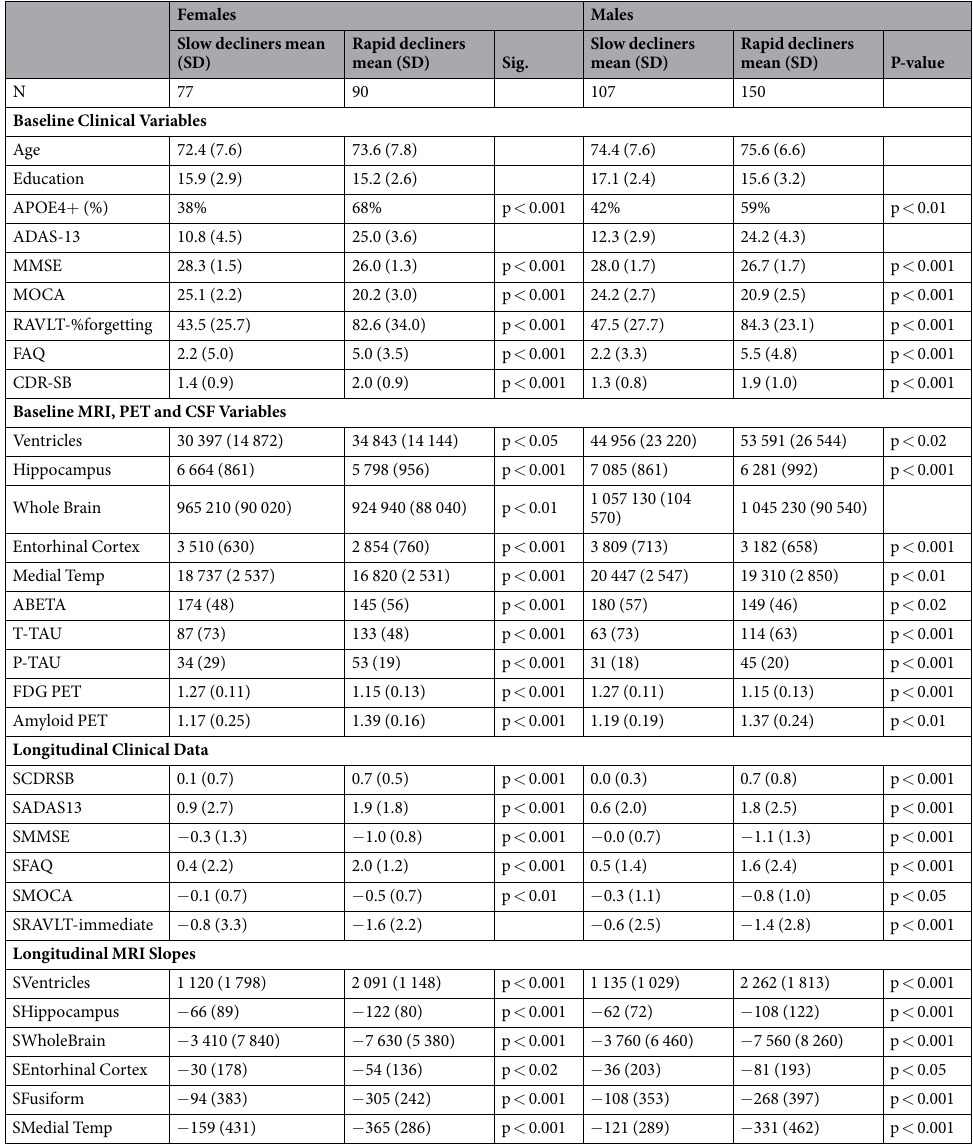
Table 5. Sex-specific clinical and biomarker differences between MCI